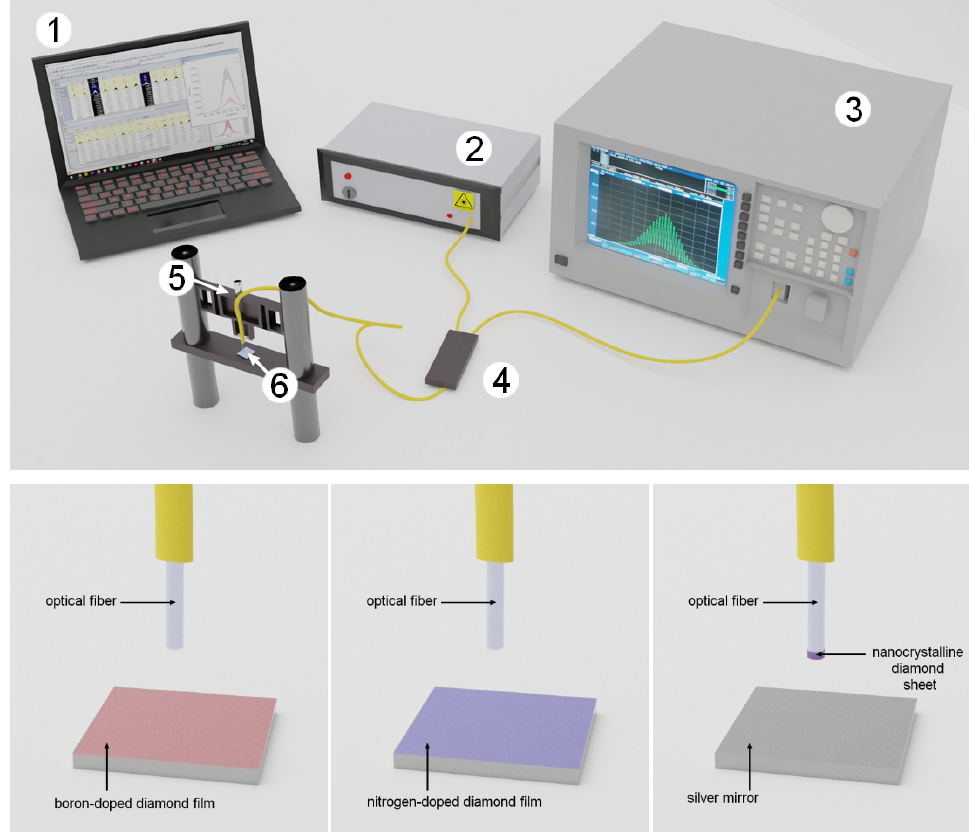
Figure 3. Measurement setup for the cavity parameters assessment. 1—PC; 2—light source; 3—optical spec- trum analyzer; 4—2 × 1 fiber coupler; 5—micromechanical setup; 6—cavity; R 1 –R 6 —surfaces reflectivities.